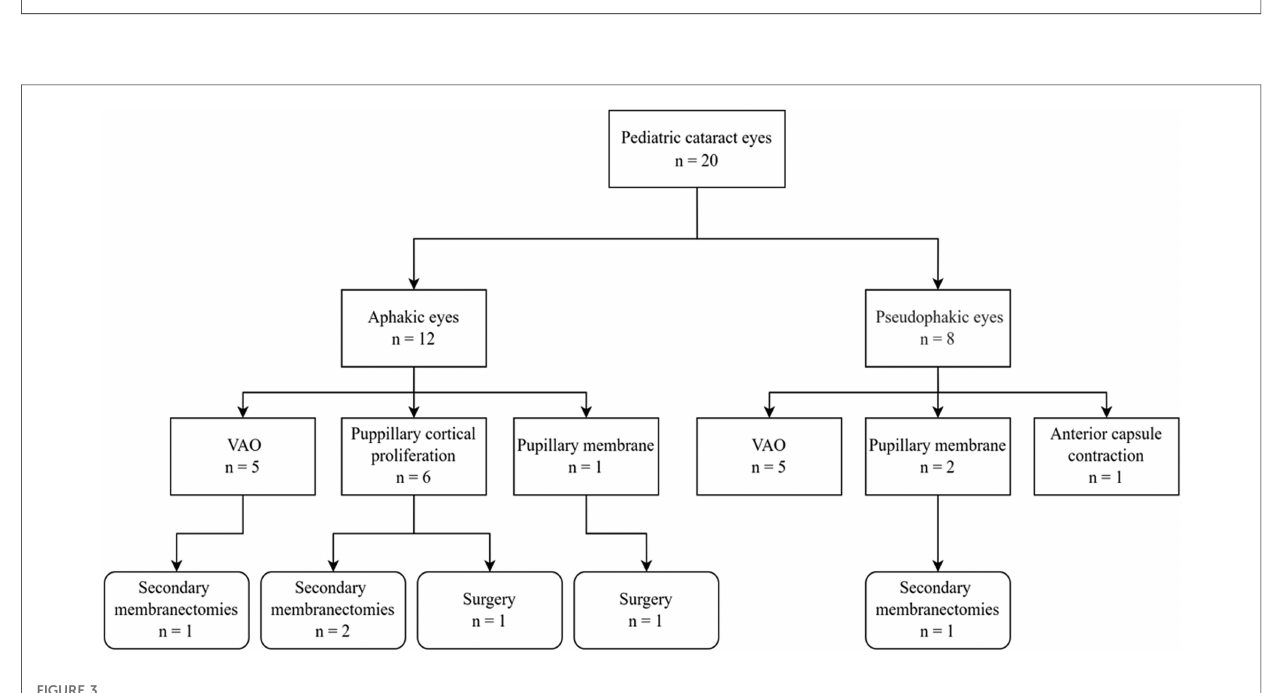
FIGURE 3 Targets of Nd:YAG laser treatment for the enrolled